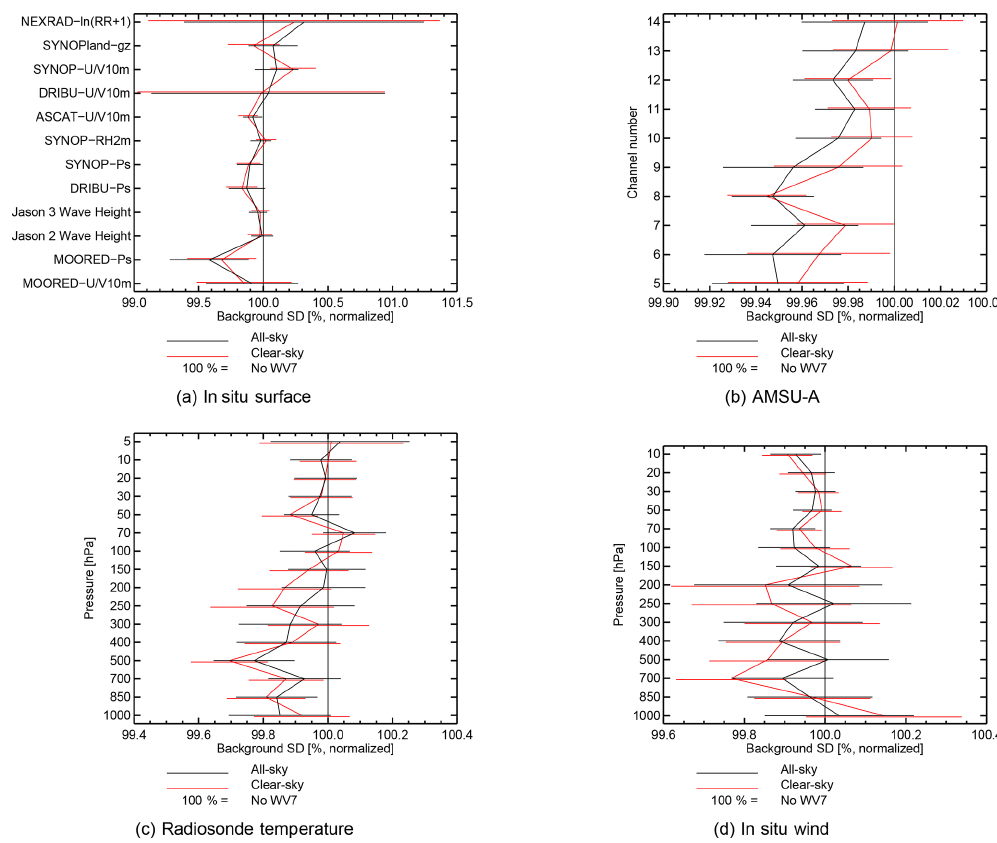
Figure 15. As in Fig. 14 but for another selection of observing systems with pressure, wind and temperature sensitivity: (a) surface observa- tions; (b) microwave temperature sounder AMSU-A; (c) temperature radiosondes; and (d) in situ wind measurements from sondes, profilers, and aircraft